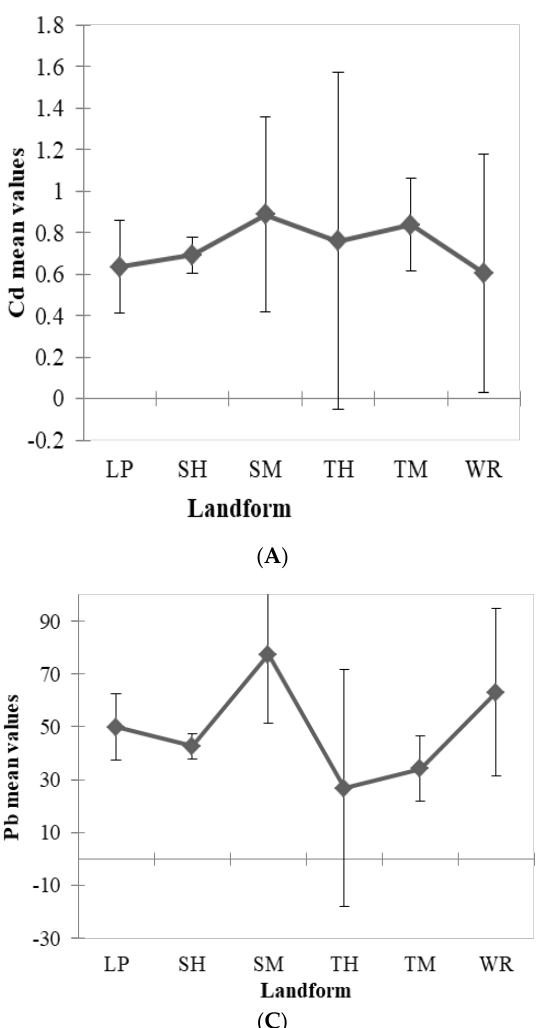
Figure 6. The effect of landform on ( A ) Cd, ( B ) As, and ( C ) Pb contents. Additionally, sandstone and shale had increased Cd contents (0.98 ± 0.15 mg/g and 0.96 ± 0.08 mg/g) compared to other lithologies, followed by marine rock, ignimbrite, granite, bauxite, gneiss, fluvial, and siltstone (Figure 7A). Marine unconsolidated rock had the highest content of As (19.63 ± 0.45 mg/g), followed by, in decreasing order, sandstone, megmatite, siltstone, granite, shale, ignimbrite, fluvial, and finally weathered residuum lithology (Figure 7B). The inland water lithology had higher Pb contents with a proportion of 63.05 mg/g, followed by fluvial, bauxite, ignimbrite, marine unconsolidated rock, megmatite, claystone, sandstone, granite, and shale (Figure 7C).